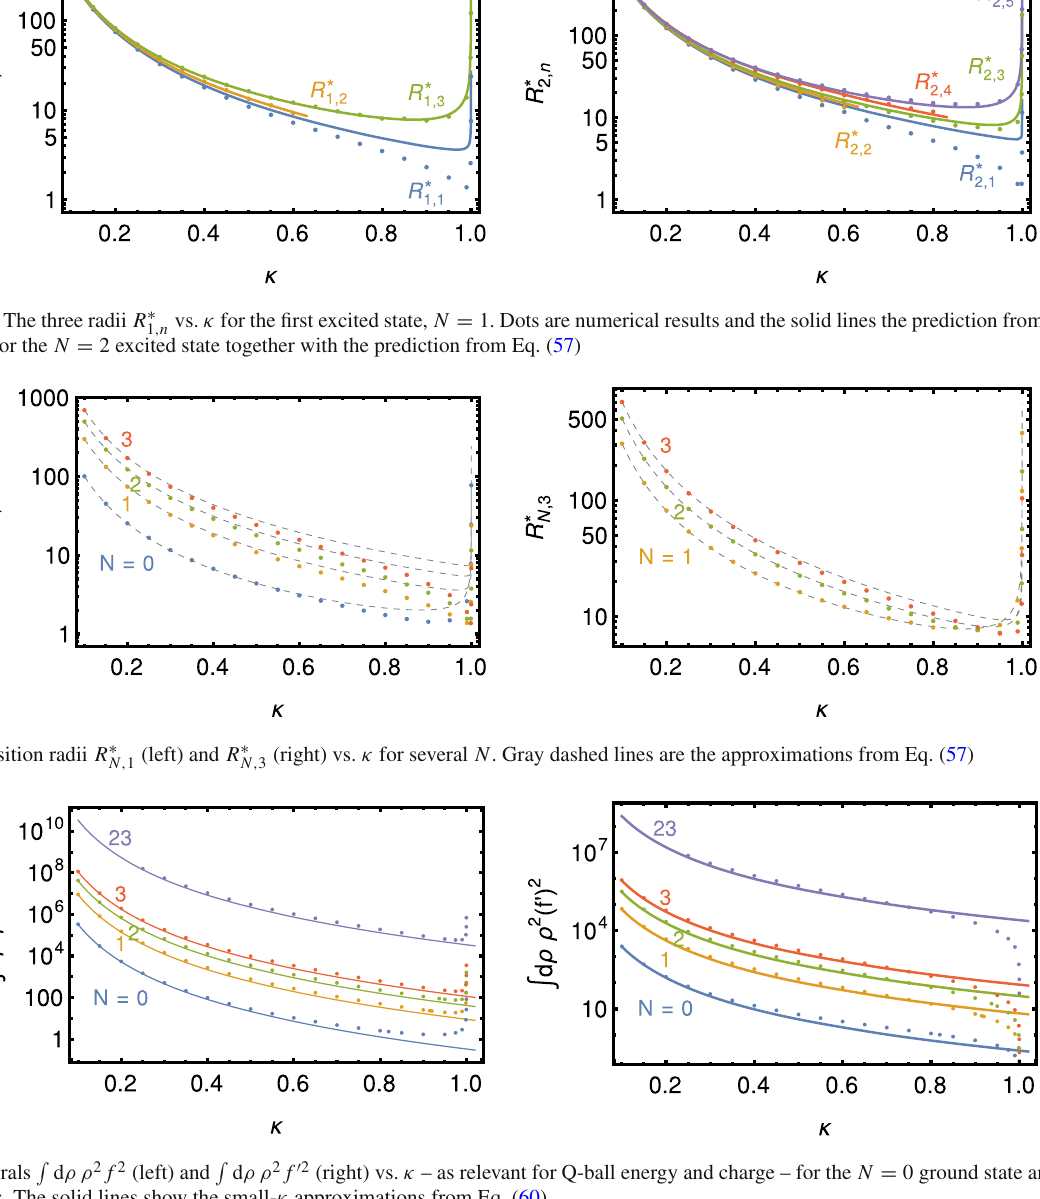
(cid:15) (cid:15) Fig. 6 Integrals d ρ ρ 2 f 2 (left) and d ρ ρ 2 f (cid:12) 2 (right) vs. κ – as relevant for Q-ball energy and charge – for the N = 0 ground state and several excited states. The solid lines show the small- κ approximations from Eq. (60)